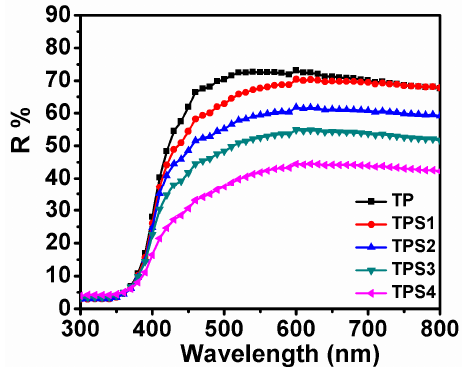
Figure 5. Diffuse reflectance spectra of the TP, TPS1, TPS2, TPS3, and TPS4 films.